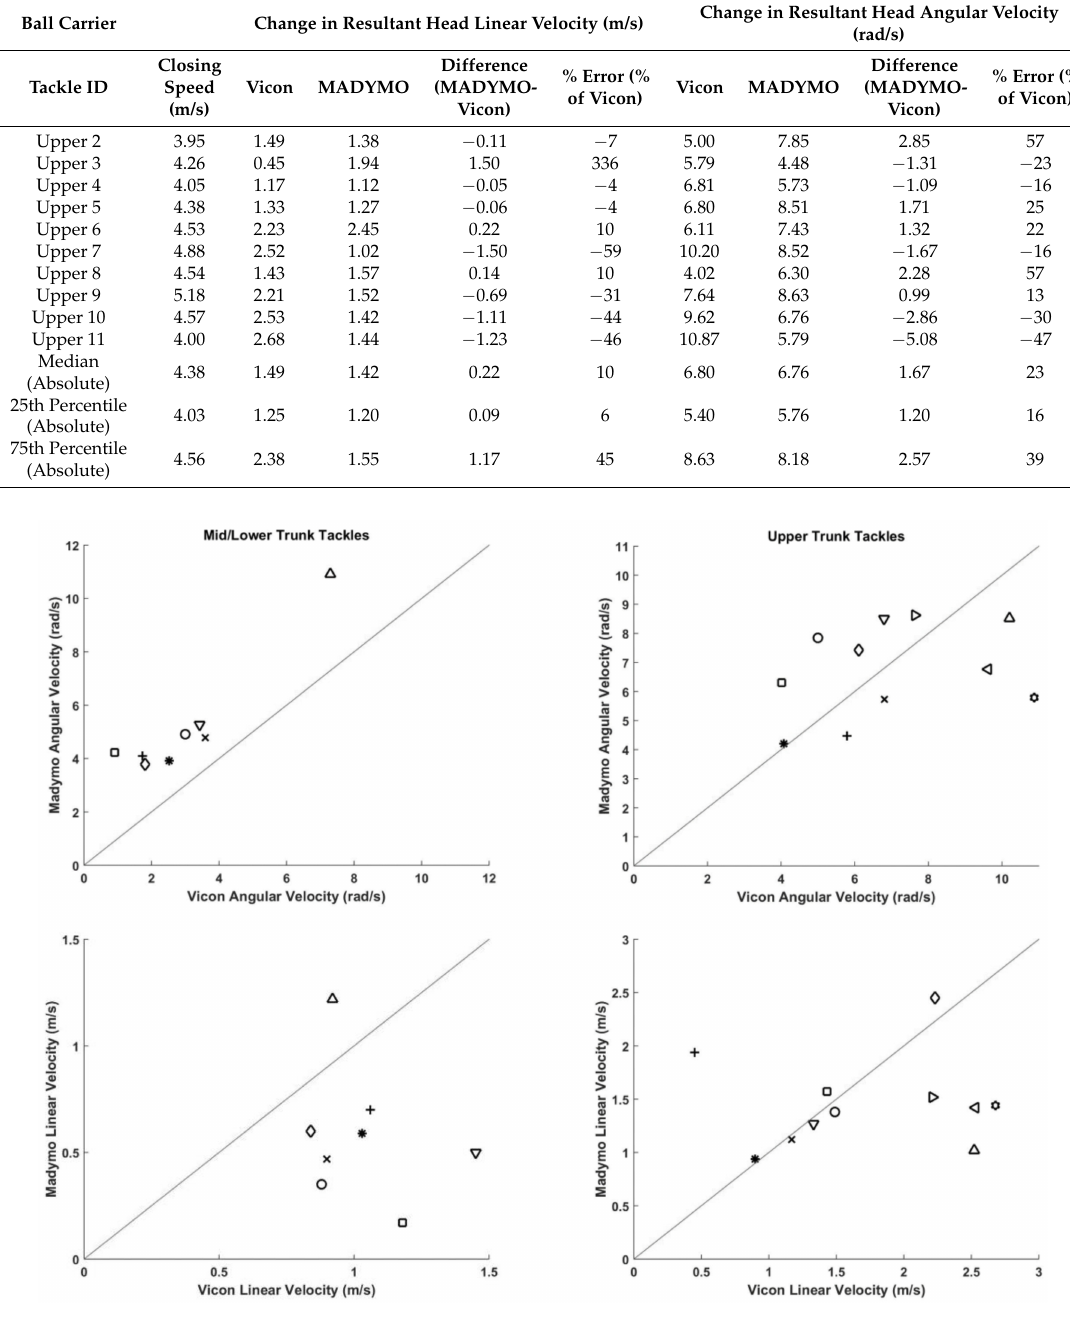
Figure 3. Comparison between the predicted multibody model (MADYMO) and 3D motion laboratory (Vicon) peak ball carrier change in resultant head angular and linear velocity for upper and mid/lower trunk tackles. Each symbol corresponds to a tackle and is matched for both